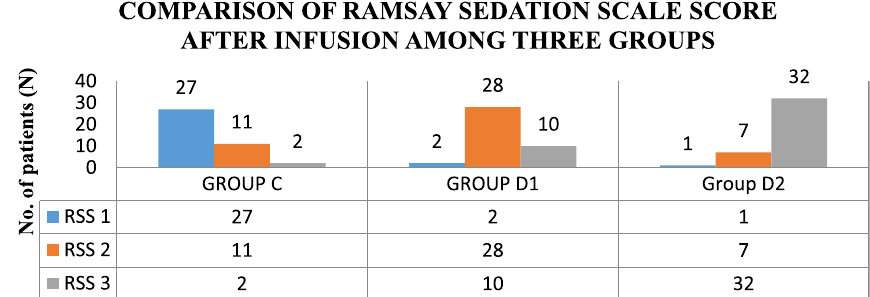
Fig. 7 Comparison of Ramsay Sedation Scale (RSS) score after infusion of study drug among three